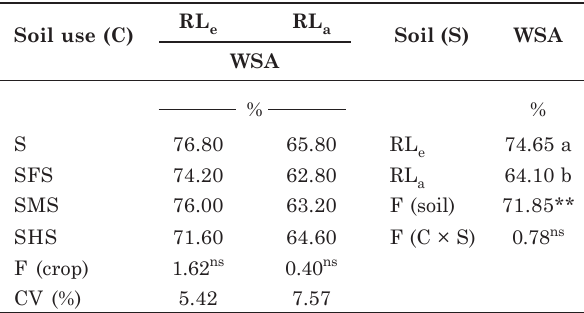
S: soybean, SFS: soybean/fallow/soybean, SMS: soybean/millet/ soybean, SHS: soybean/sunn hemp/soybean. Values followed by an identical letter in the same column were not significantly different as per Tukey’s test at α =0.05. ns not significant, ** significant at the p=0.01